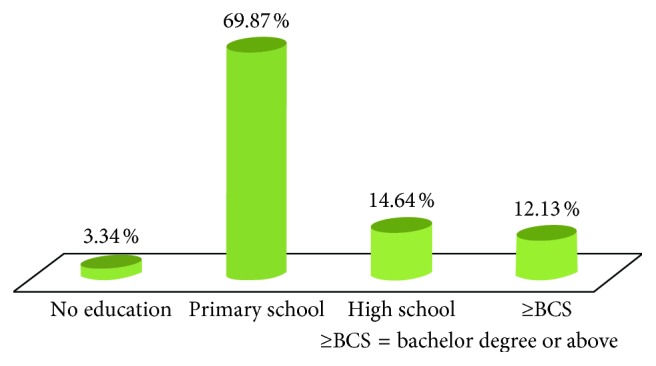
Education level.